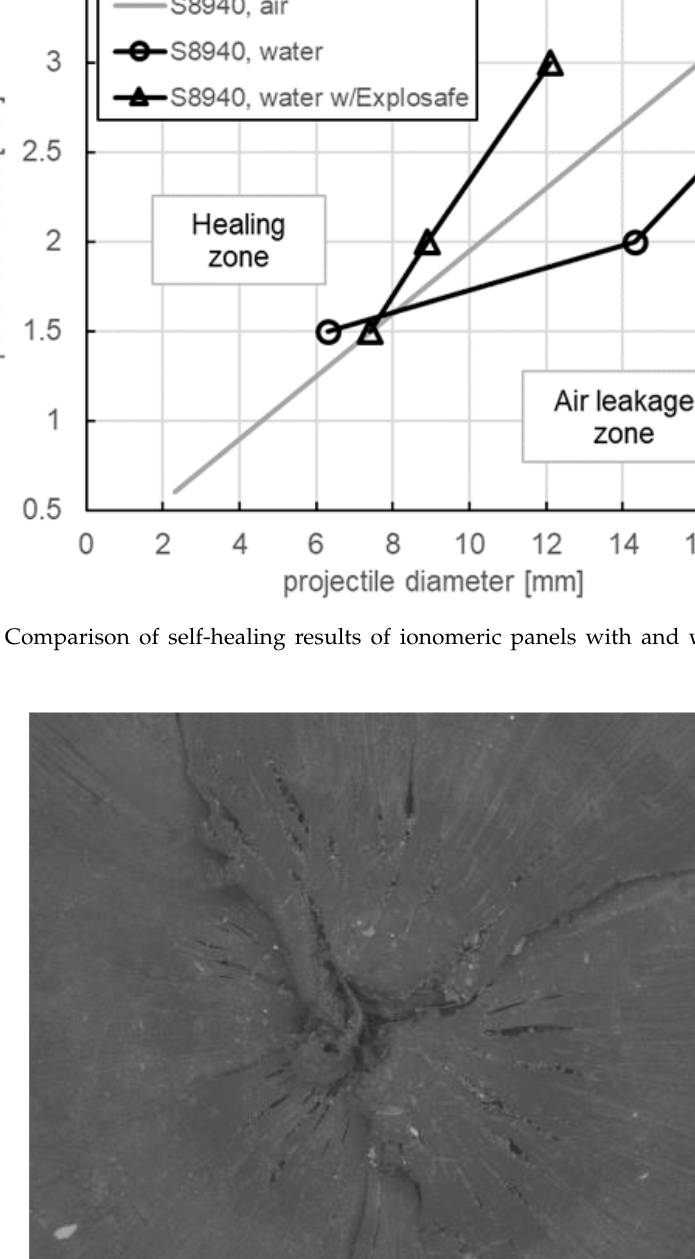
Table 4. Results of ballistic tests with a pressurized tank.